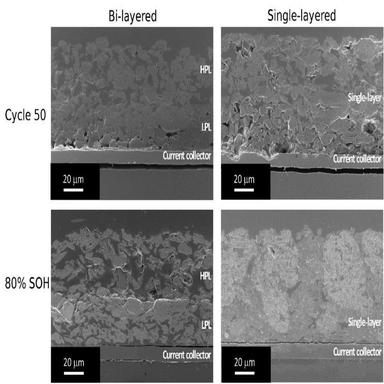
FE-SEM images at X1000 magnification of the cross section of the bi-layered and the single-layered electrodes after 50 galvanostatic cycles and at their end of life (80% SOH).